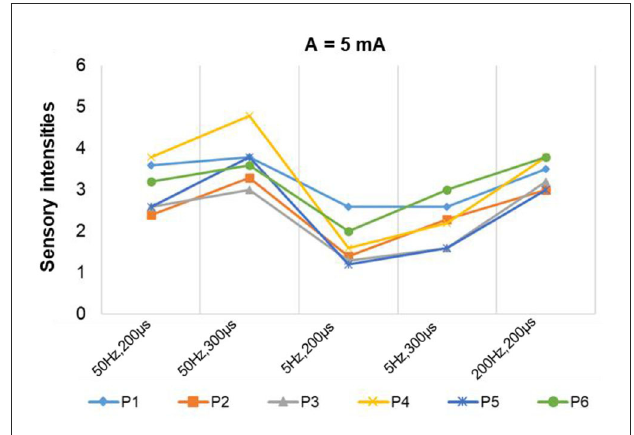
FIGURE11 The stimulus parameters and the sensation intensities under the MS mode.